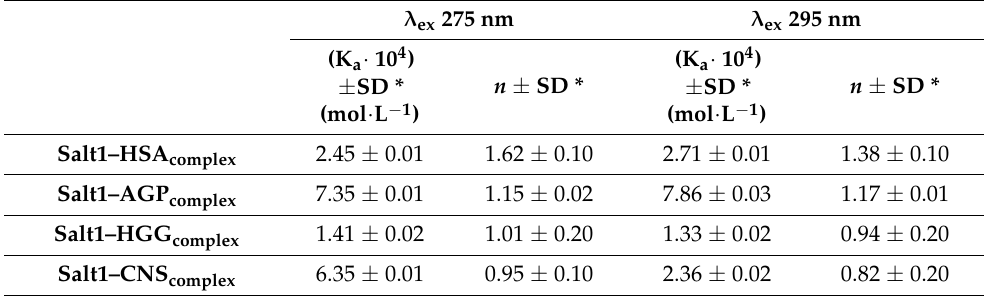
Table 6. The binding parameters for Salt1–HSA, Salt1–AGP, Salt1–HGG and Salt1–CNS